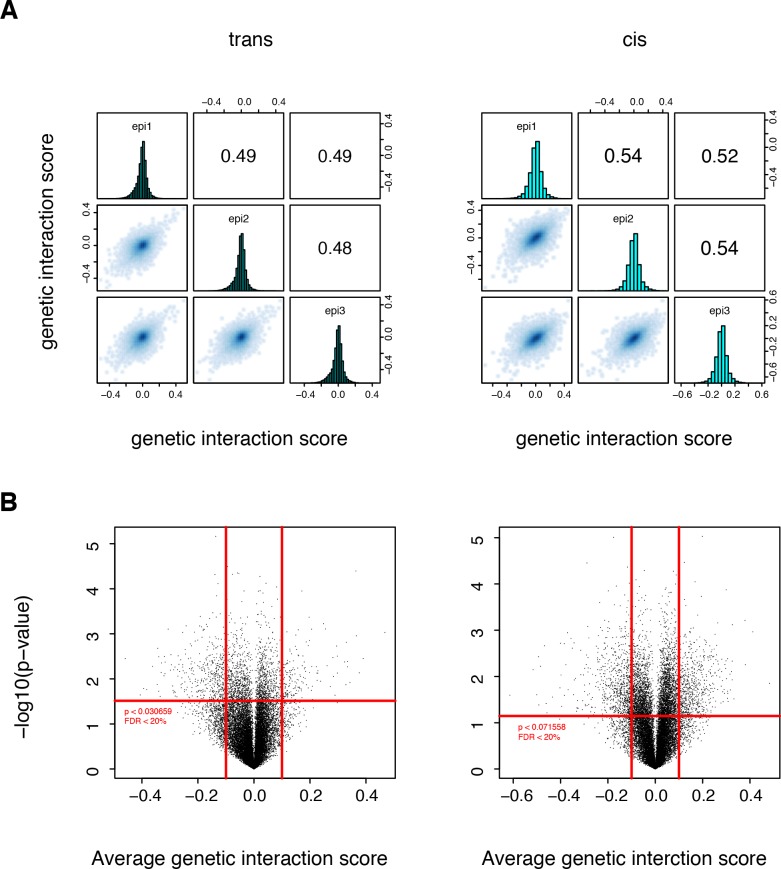
Significant structural genetic interactions in cis and trans.(A) Correlation of structural genetic interaction scores between the three replicates of each library. Genetic interaction scores are from the thermodynamic model fitted on the two original libraries pooled together. (B) Volcano plot of the p-values of each double mutant as a function of the corresponding average genetic interaction scores. Data from the original libraries (not sub-sampled). Red lines represent the thresholds that were used to define the strong and significant genetic interactions used to compute the enrichment in structural features. Vertical lines, magnitude thresholds. Horizontal line, p-value threshold that corresponds to a FDR of 0.2.